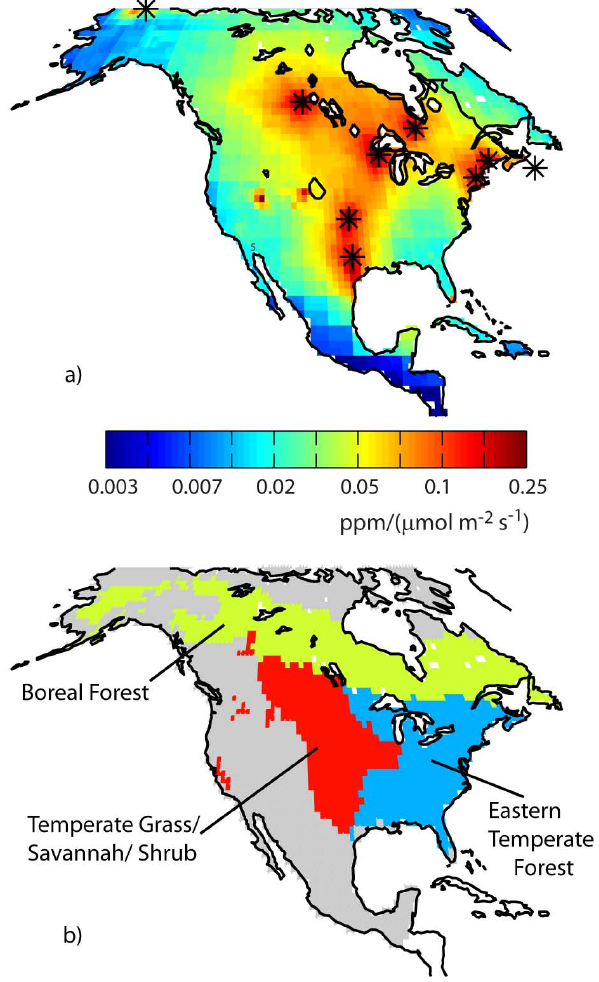
Fig. 2. (a) Sensitivities of all observations used in the inversion (as shown in Table A1 in the Supplement) to flux estimates, averaged across all 3-hourly flux time periods for the year for each grid-cell location. Black stars represent the nine continuous measurement locations in 2004. (b) Three ecoregions (modified from Olson et al., 2001) used for spatial aggregation of flux estimates. These three ecoregions, along with the grey grid-cells, form the domain for the aggregated North American totals in Figs. 5 and